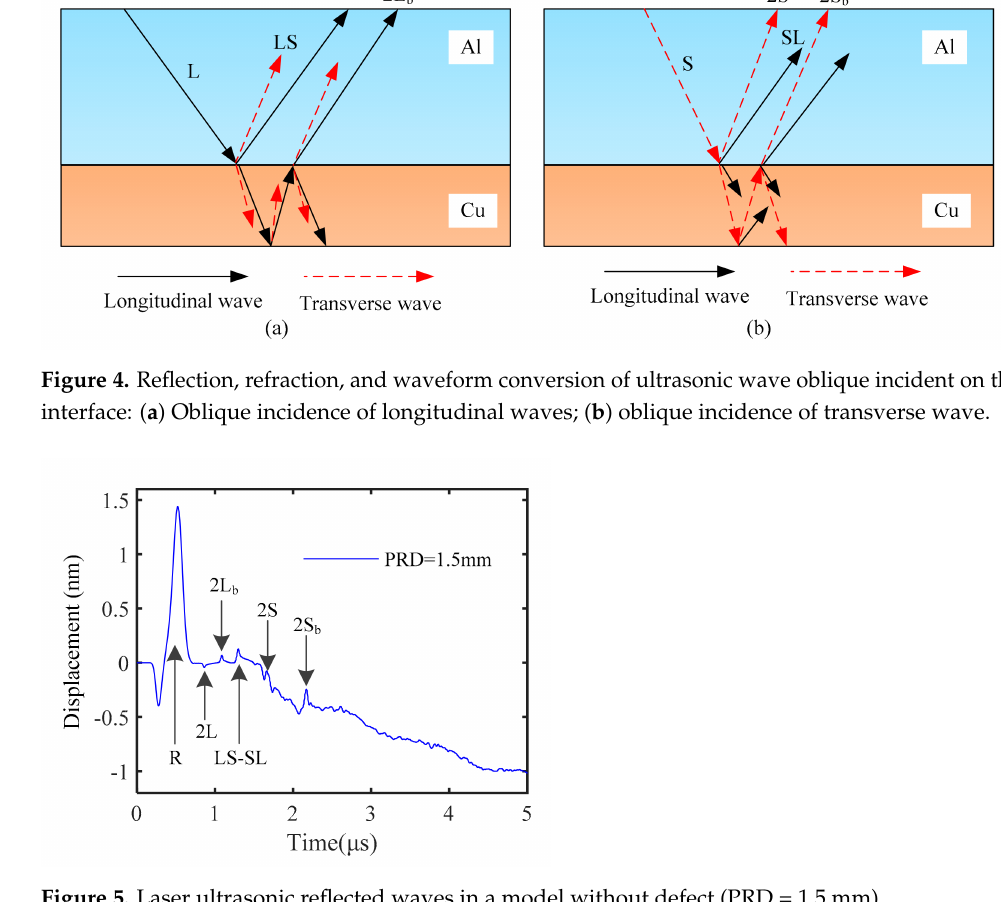
Figure 5. Laser ultrasonic reflected waves in a model without defect (PRD = 1.5